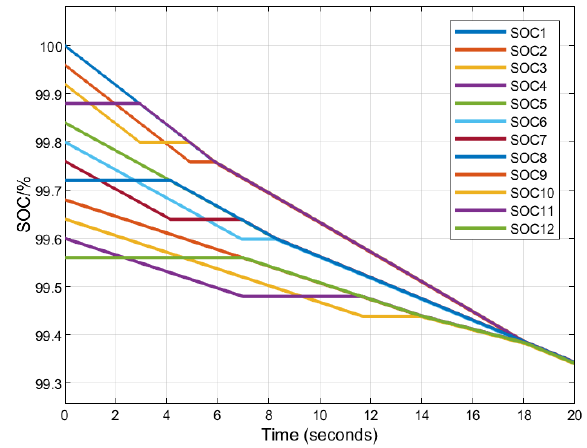
Figure 15. Equalization process of battery